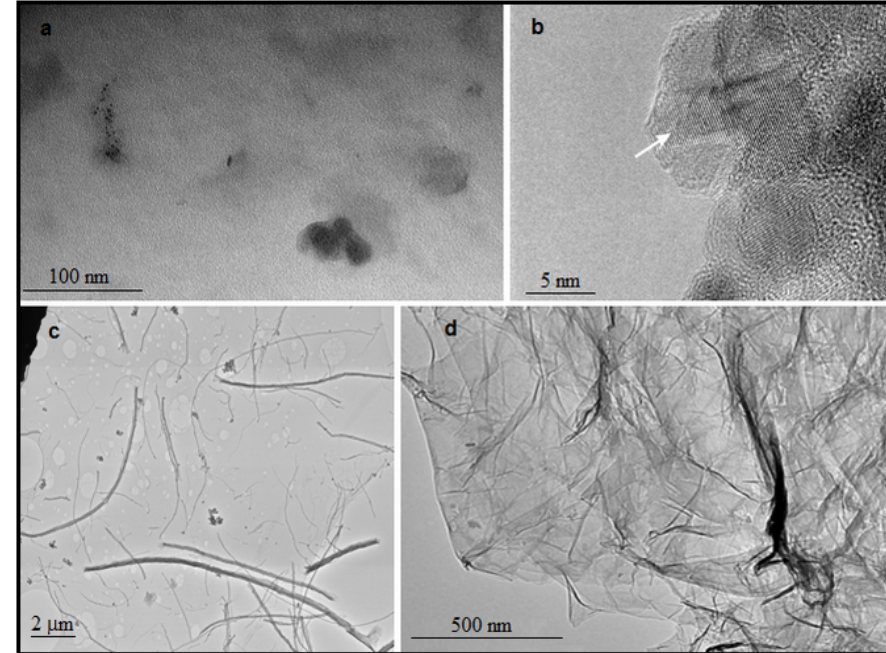
Figure 3. ( a ) TEM/HR-TEM images of different carbon nanomaterials: C 60 nanoparticles (scale bar = 100 nm), original figure; ( b ) nanodiamonds (scale bar = 5 nm), adapted from [26], ( c ) carbon nanotubes (CNTs) (scale bar = 2 μm), original figure; ( d ) graphene oxide (scale bar = 500 nm), adapted from [27].